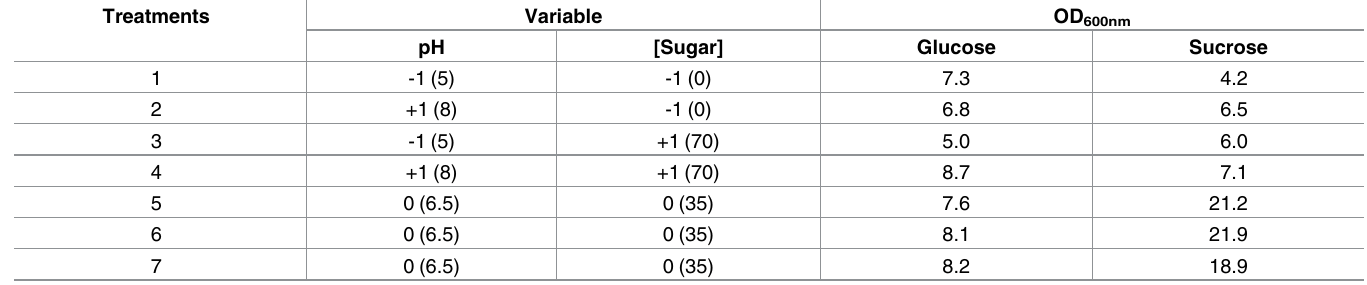
OD 600nm , optical density.